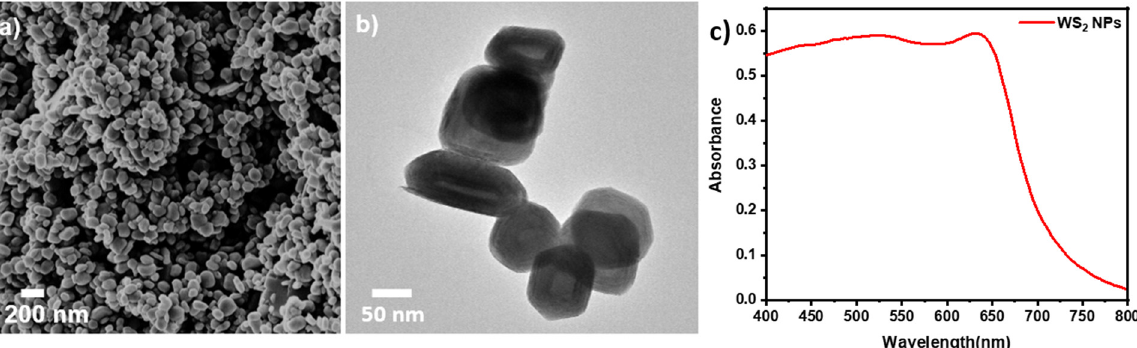
Figure 1. ( a ) SEM image of WS 2 NPs, ( b ) TEM image of WS 2 NPs. ( c ) absorption spectrum of WS 2 NPs.